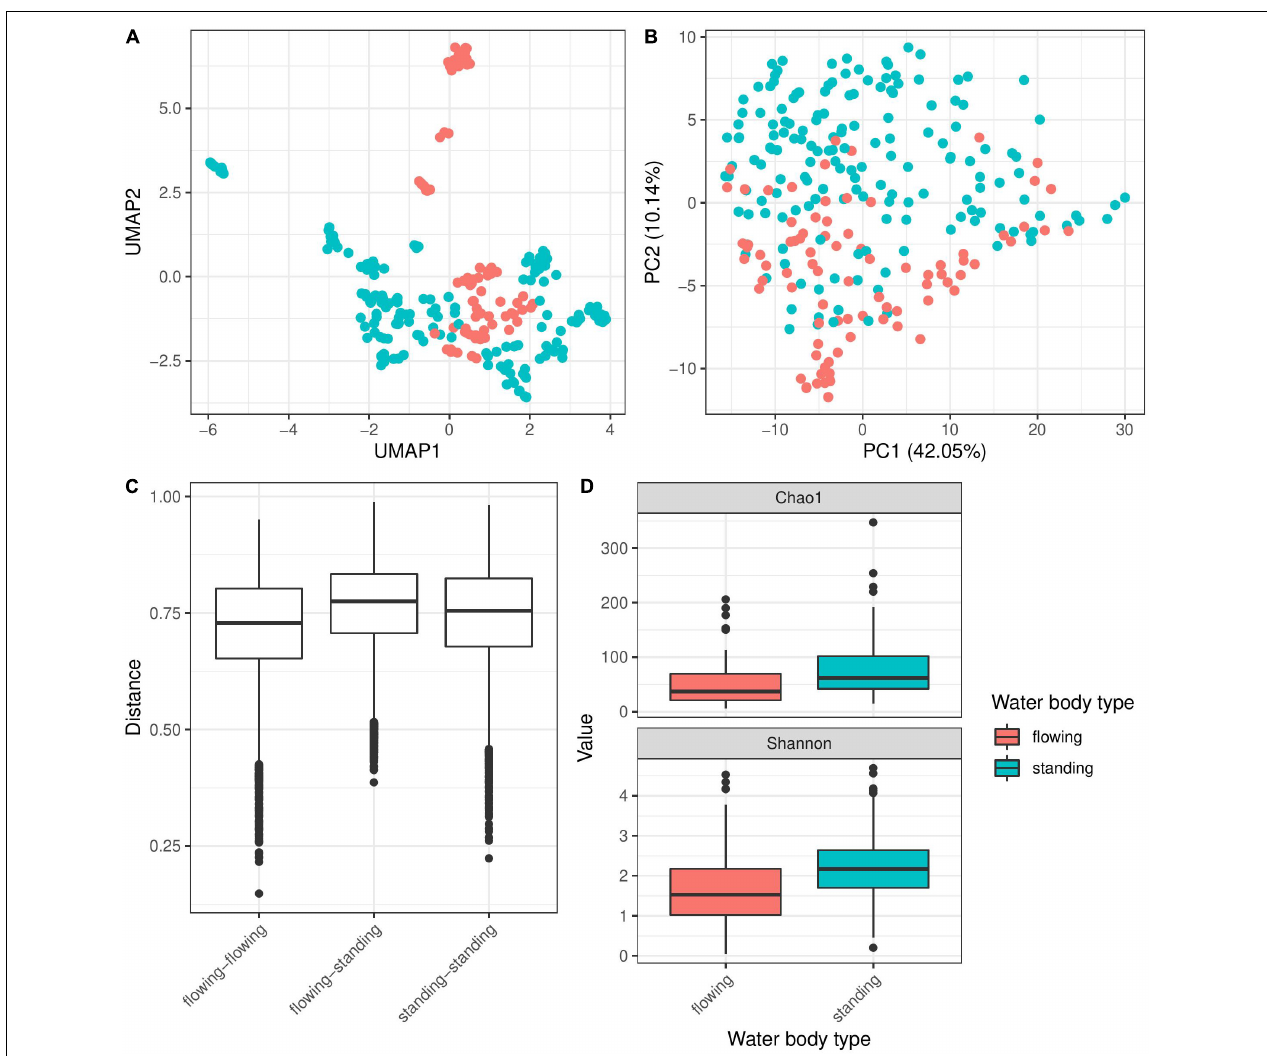
FIGURE 3 | Influence of water body type on bacterial colonization in Hydra . UMAP dimensionality reduction (A) and more clearly PC-analysis (B) of β -diversity (Bray–Curtis) show separation of the samples by water body type. This separation of microbial communities is supported by PERMANOVA test ( R 2 = 0.04, p ≤ 0.001 and R 2 = 0.03, p ≤ 0.001 with 999 permutations each for univariate and multivariate PERMANOVA). Bray–Curtis (C) dissimilarities are smallest between flowing water bodies, while dissimilarities between standing only and flowing and standing water bodies are higher. In support of this result, α -diversity is significantly smaller in flowing water than in standing water bodies for α -diversity measures chao 1 and Shannon (D) (univariate linear model: p ≤ 0.001, multivariate linear mixed model on Shannon index with population ID as random effect p ≤